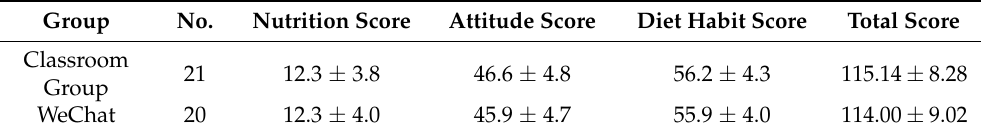
Table 3. Athlete nutrition KAP questionnaire score (N = 41).